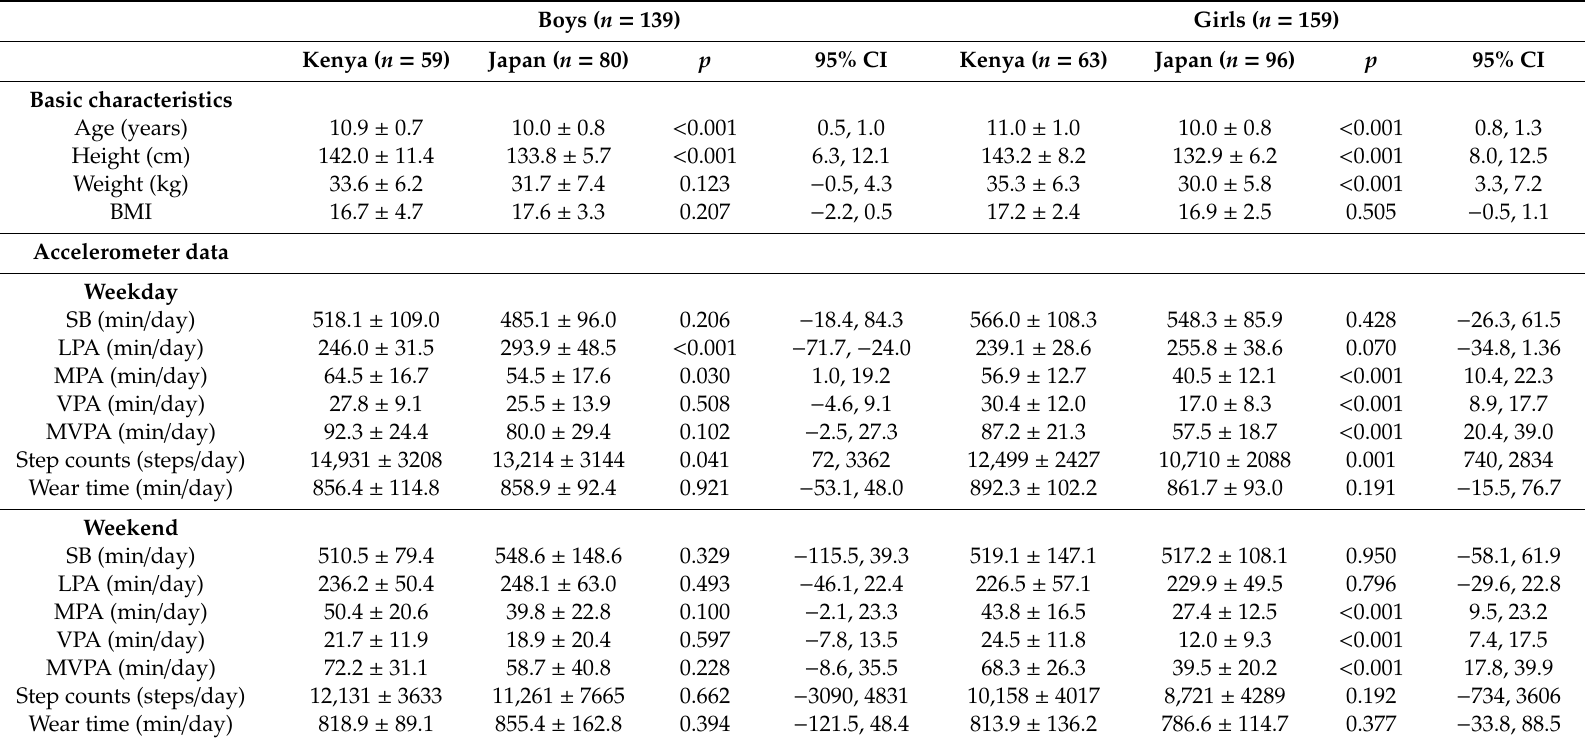
Table 1. Basic characteristics of the participants, objectively measured physical activity, and sedentary